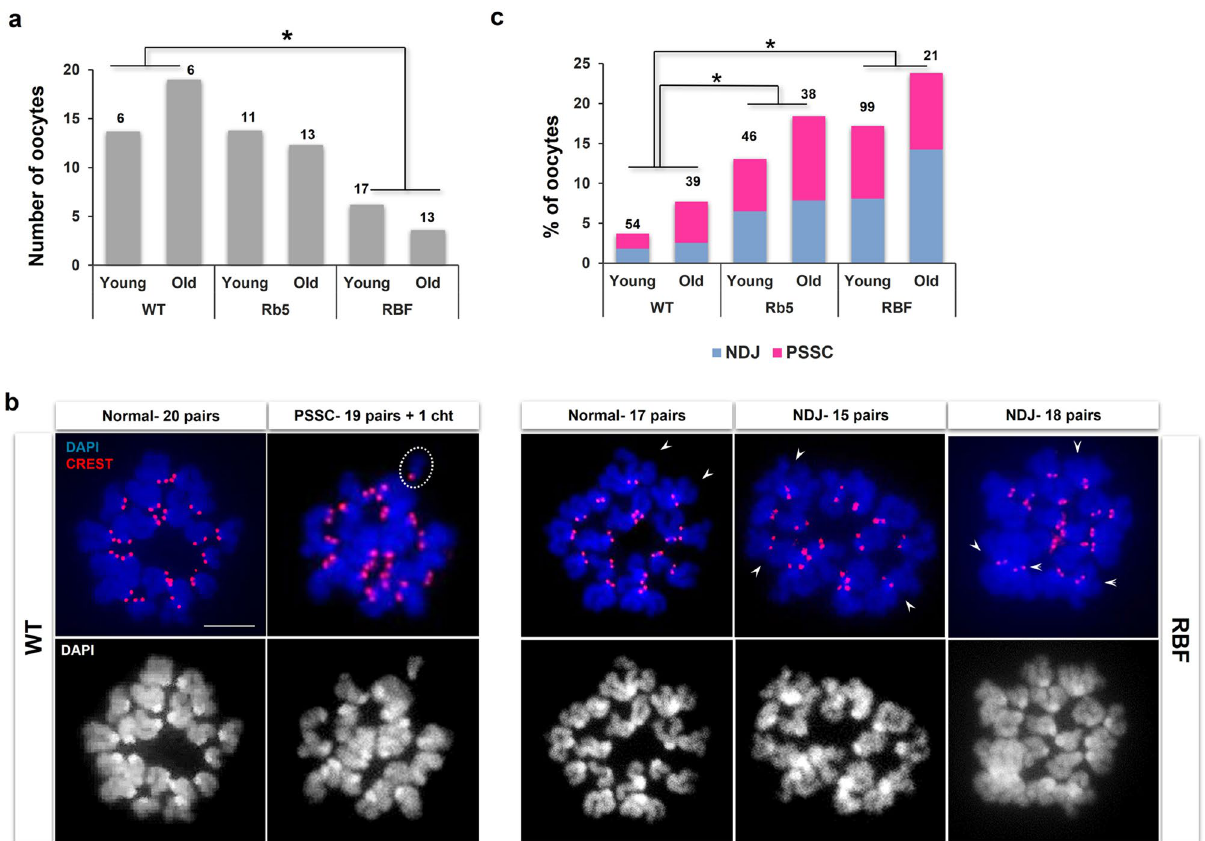
Figure 5. Aneuploidy in MII-oocytes ovulated by RbT-carrier and WT females. ( a ) The average number of ovulated oocytes by WT, Rb5, and RBF young (3–4 months) or old (6–9 months) females. The total number of examined mice is given on the top of each column. *Significant difference at P < 0.05 by Mann–Whitney test. ( b ) Representative images of nondisjunction (NDJ) and precocious separation of sister chromatids (PSSC) aneuploidy. White circle with broken line indicates a single chromatid (Cht) as the PSSC type aneuploidy. Arrowhead indicates an RbT chromosome. Scale bar 10 µm. ( c ) The rate of NDJ and PSSC aneuploidy in the oocytes from young vs. old females as shown in ( a ). The total number of examined oocytes is given on the top of each column. *Significant difference at P < 0.05 by χ 2